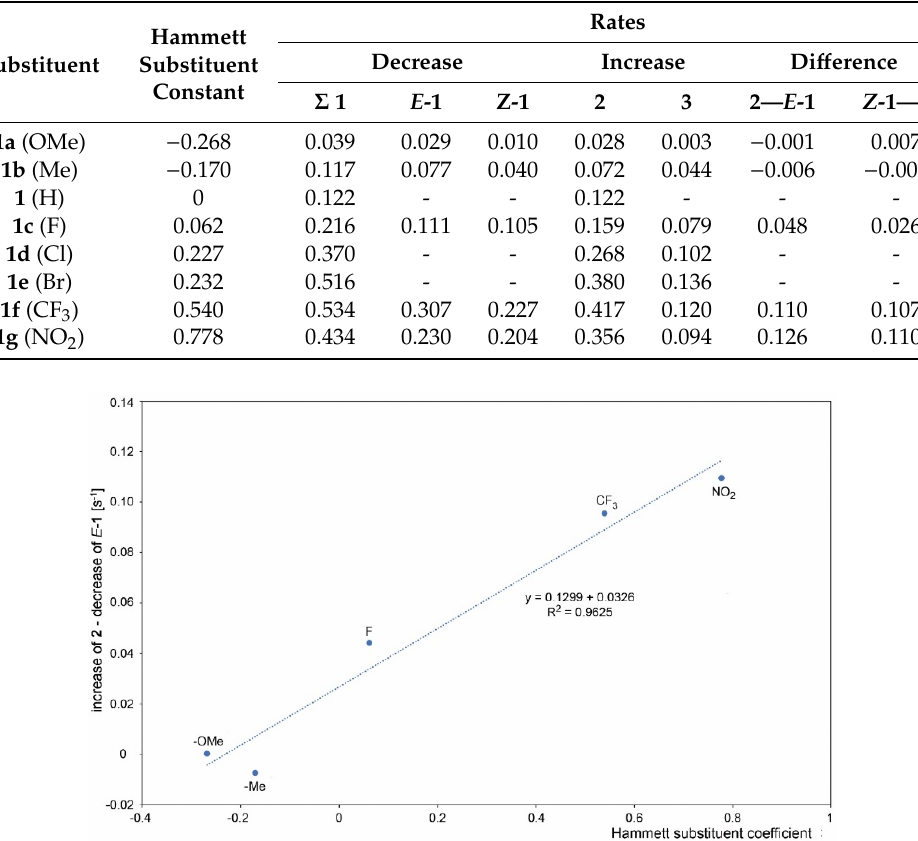
Figure 3. Monitoring of reaction kinetics of 1g . The trendlines indicate a linear part of the dependence used for calculation of the reaction rates. Table 2. Summary of photocyclization kinetics performed on the series of imines 1a-g.